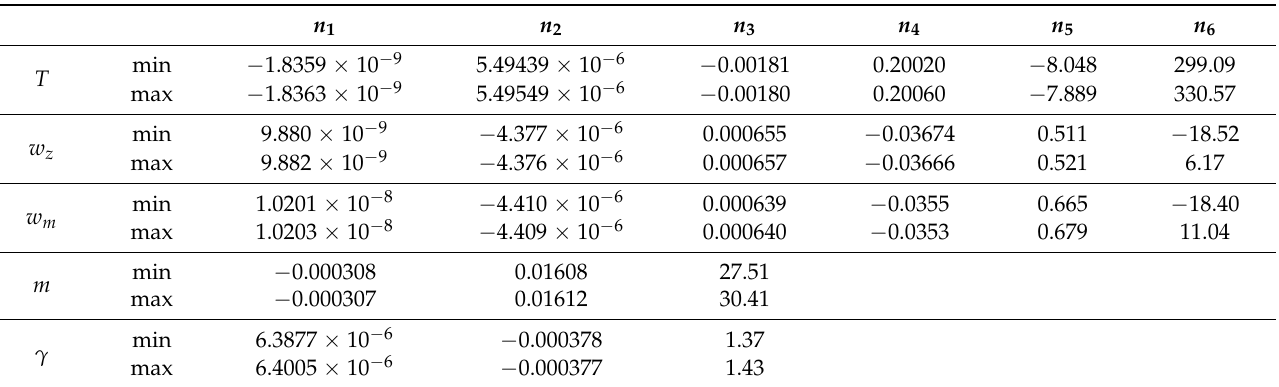
Table 1. The range of values of the polynomial curve fitting coefficients for the five atmospheric